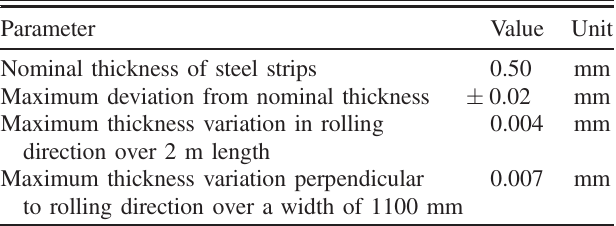
TABLE III. Dimensions of the electrical steel